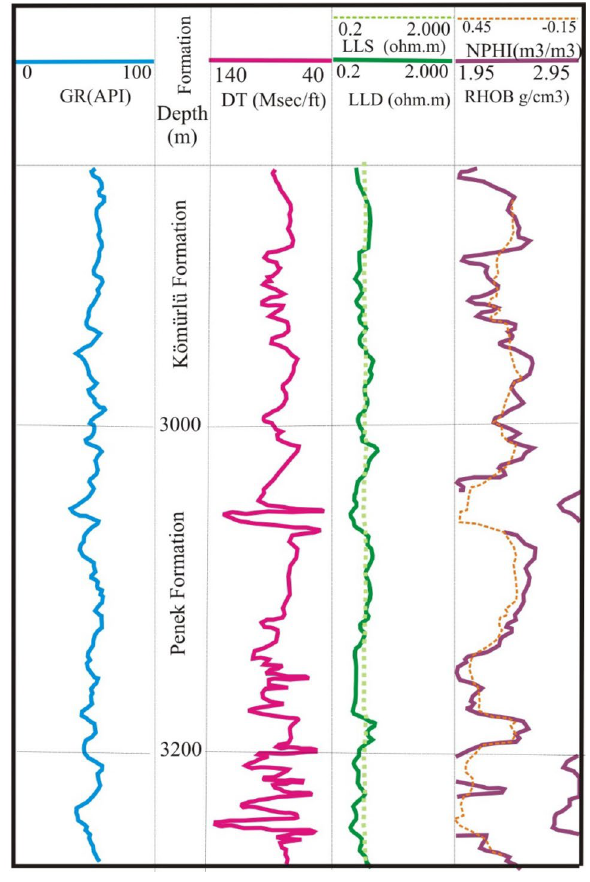
Fig. 12 Well logs of the Kömürlü and Penek